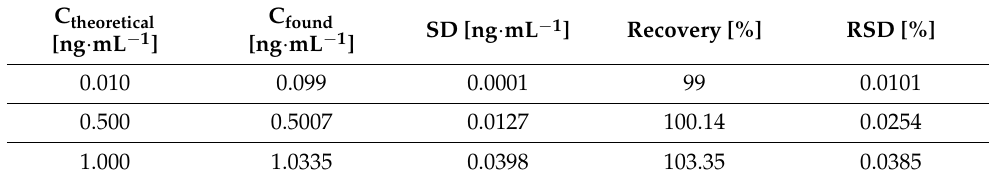
Table 1. Precision and accuracy of methods for the determination of PARP-1 concentration ( n = 24). C theoretical [ng · mL − 1